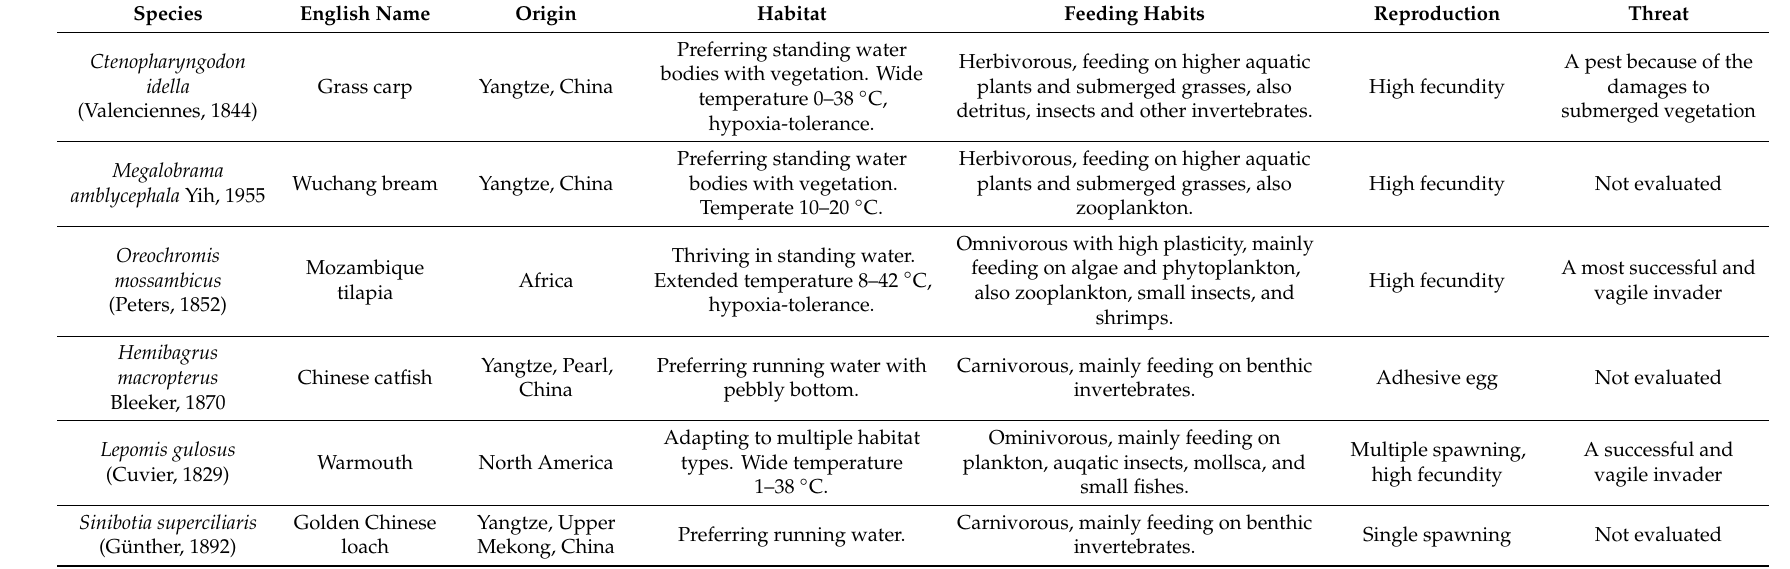
Table 2. Biological and ecological traits of invasive species into the Min River. Feeding habits and reproduction data were derived from www.fishbase.org; habitat data was measured and recorded in